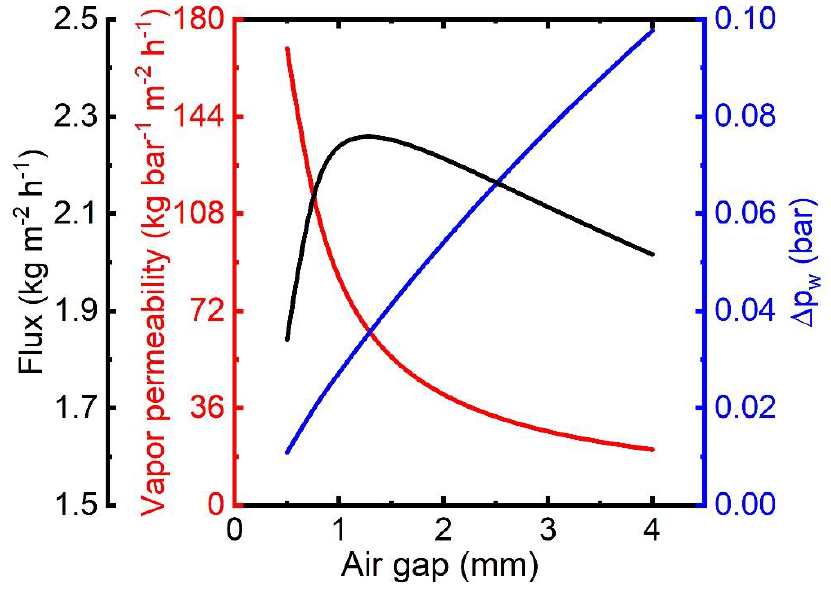
Figure 11. Flux, vapor permeability, and vapor pressure difference profile with varying gap thick- ness.